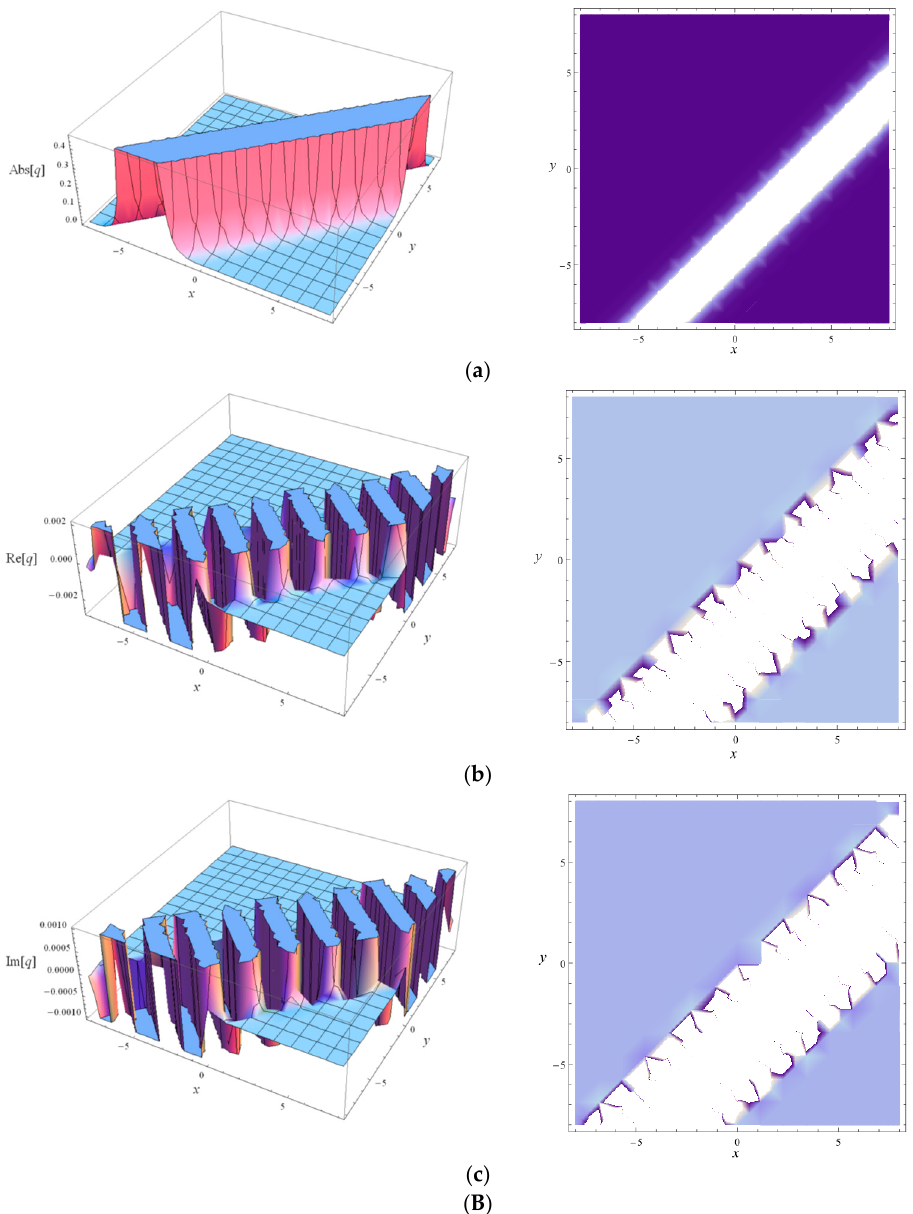
= t . ( A ) The performance of ( ) tyxq ,, . ( Ba )